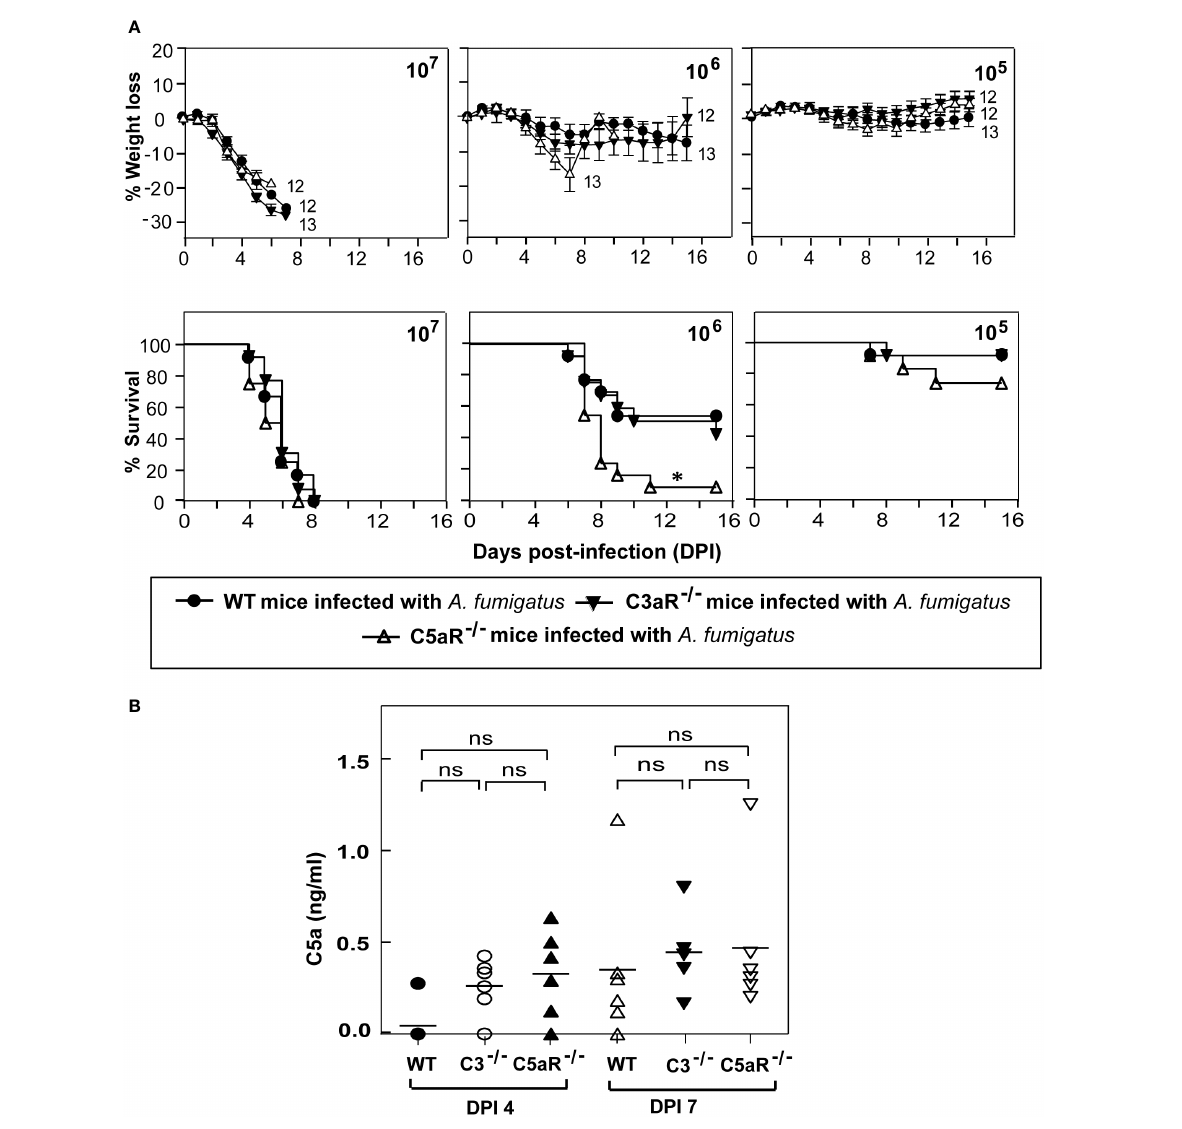
FIGURE 5 C5a receptor signaling is crucial for protecting against systemic A fumigatus infection. (A) Wild-type (WT), C3aR -/- and C5aR -/- mice (all on BALB/c background) were infected intravenously with 1x10 5 , 1x10 6 , or 1x10 7 conidia and observed for percent body weight loss and survival till day 15 post-infection. The numbers depicted at the end of each line in the weight loss graph indicate the number of animals used in that group. The C5aR -/- mice showed signi fi cantly higher mortality than the WT mice (*p < 0.01). Results represent the mean ± SEM of three independent experiments. (B) BALB/c WT, C3 - / - and C5aR - / - mice were infected intravenously with 1x10 5 conidia. Plasma samples from A fumigatus infected mice were obtained on day four and day seven post-infection. C5a levels were determined by ELISA. Results shown are mean concentrations